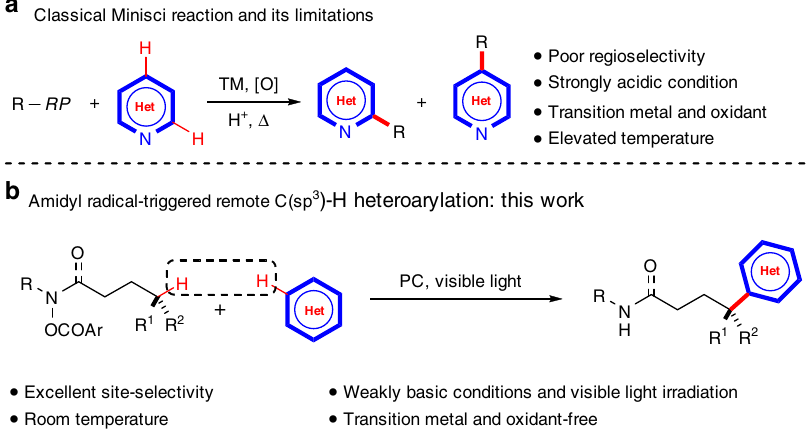
Fig. 1 Alkylation of hereroarenes. a Classical Minisci reaction and its limitations. b Amidyl radical-triggered remote C(sp 3 )-H heteroarylation: this work. RP radical